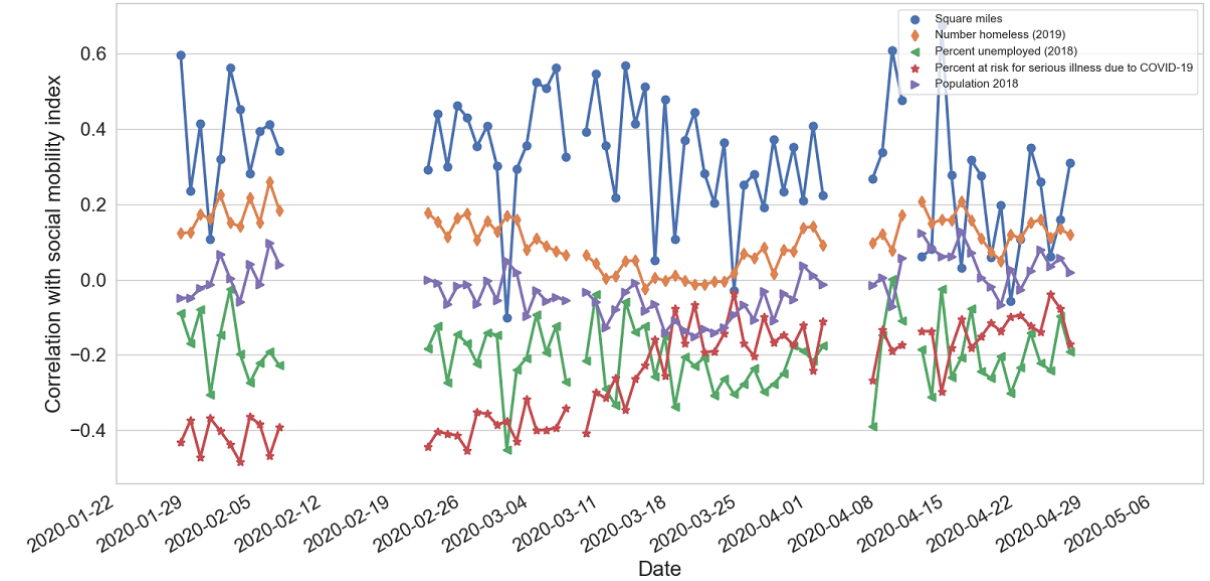
Figure 4. Pearson correlations between the social mobility index and various factors at the state